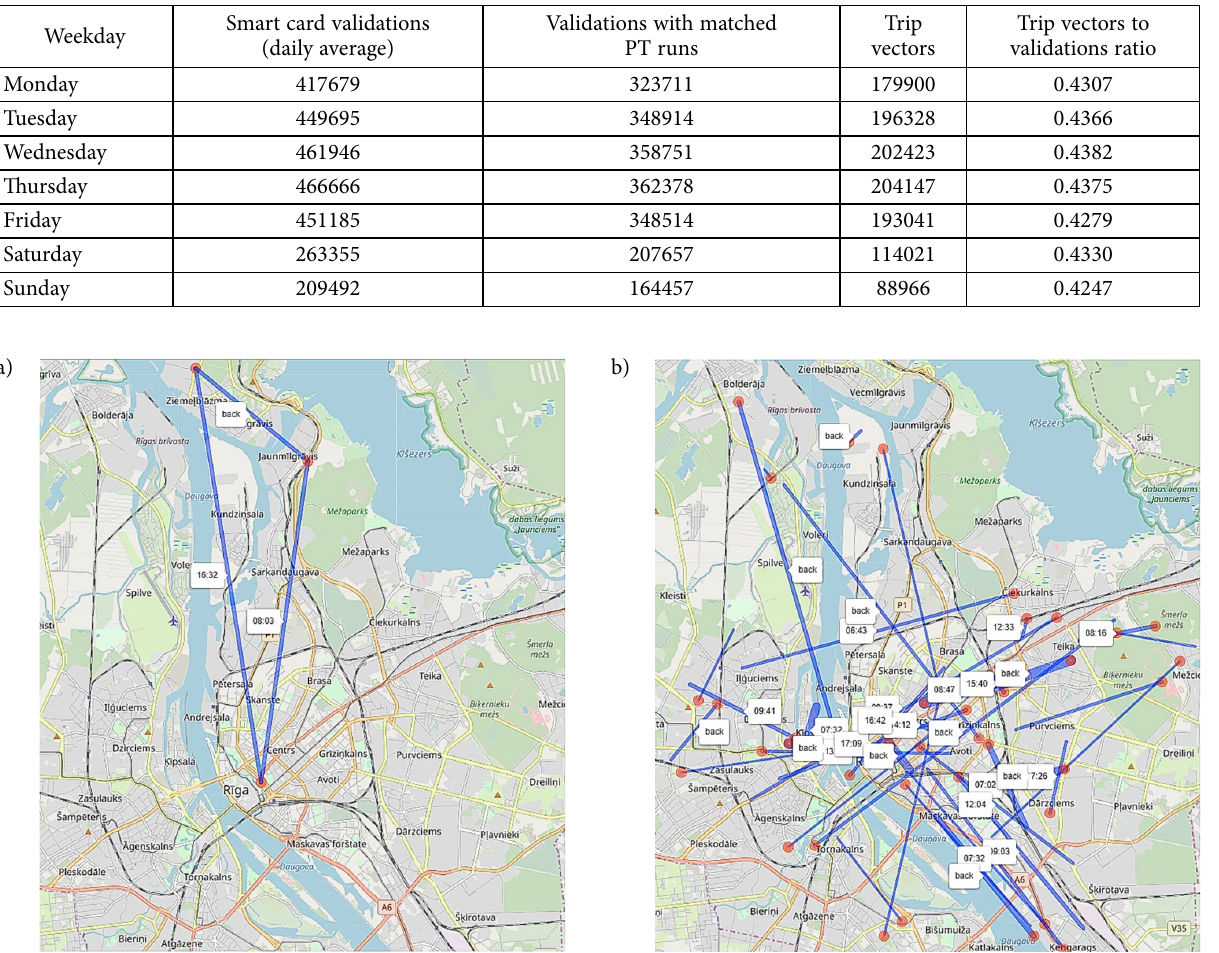
Table 3. Summary statistics of trip vector construction steps